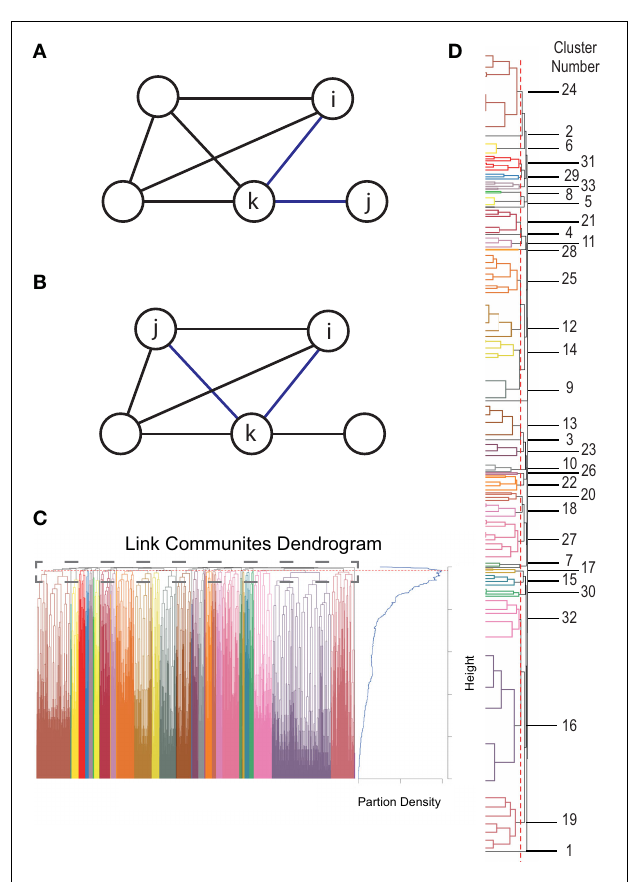
FIGURE 1 | Connectivity clustering approach. (A) Example for two connections with low similarity. The common neighborhood of vertices i and j is only k therefore the similarity is S = 1 / 3. (B) An example for two connections with high similarity. As vertices i and j have the same neighborhood the similarity is 1. (C) Dendrogram (left) based on calculated similarities together with a plot of estimated partition densities (right). Red dotted line indicates the cutoff of the dendrogram estimated by maximizing partition density. (D) Zoomed view of the top of the dendrogram from (C) together with network numbers from Figure 3